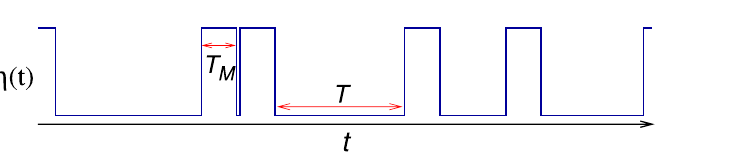
Figure 2. Scheme of the dichotomous pushing force acting on the polymer. T M is the working time of the motor, supposed fixed. T is the mean waiting time in the inactive state. The motor acts on a region of length L M , see Fig.